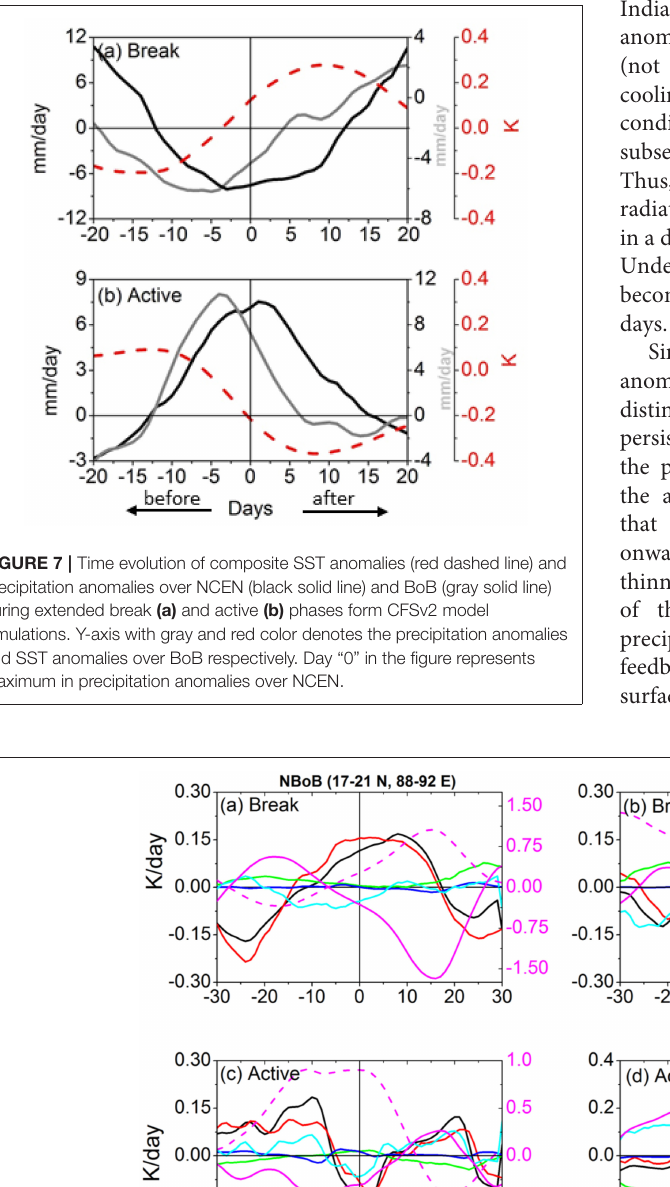
Frontiers in Earth Science |